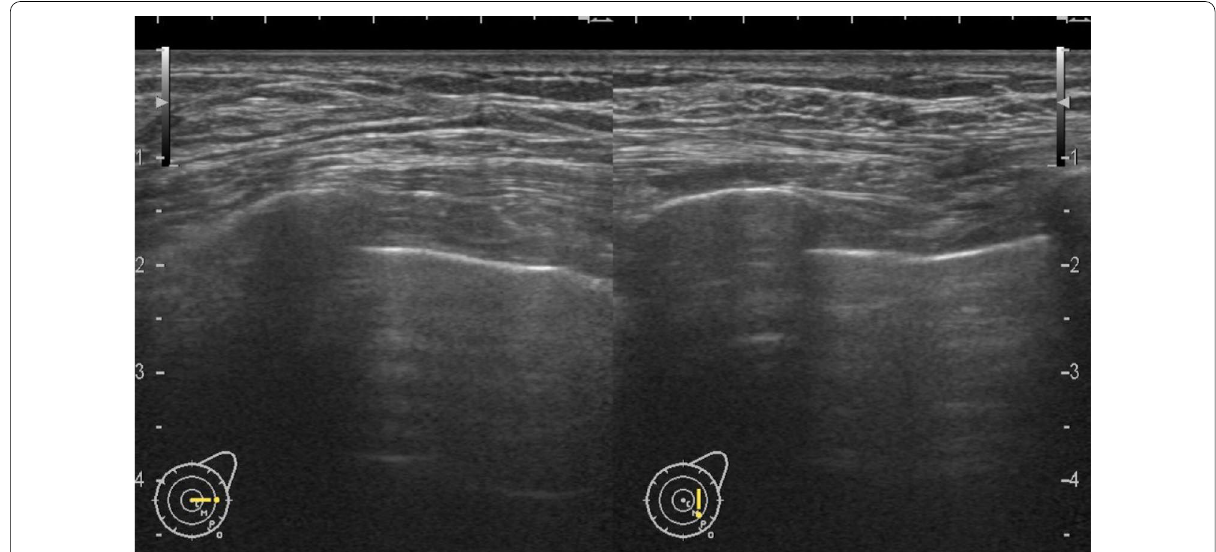
Fig. 6 A month after the patient’s first visit, we could not detect the tumor on